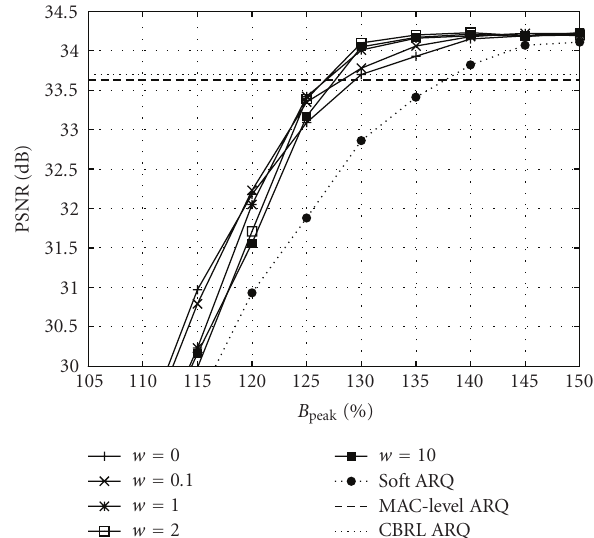
Figure 4: PSNR as a function of the peak bandwidth for the pro- posed ARQ scheme for di ff erent values of the w parameter, com- pared to the Soft ARQ technique and to the best performance of the MAC-level and CBRL ARQ schemes ( tempete sequence).